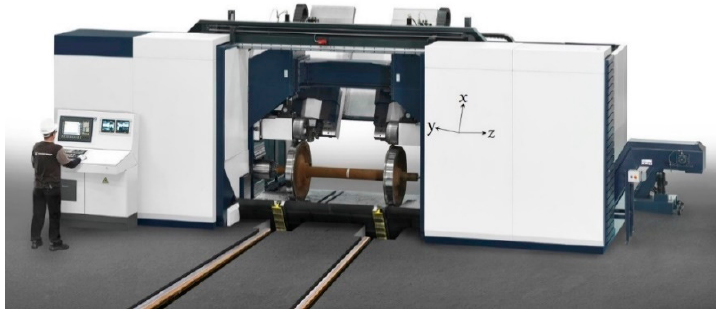
Figure 1. General view of the portal lathe.